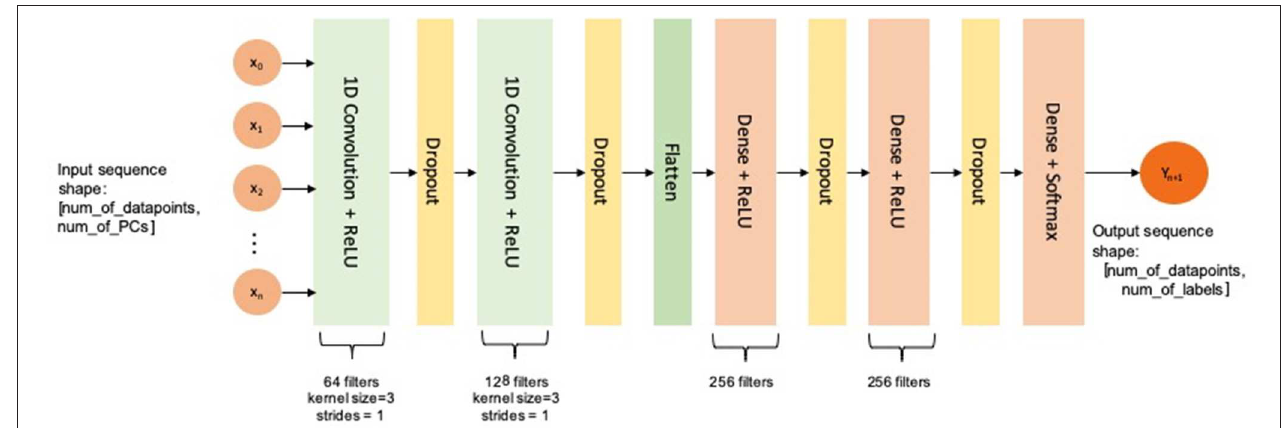
FIGURE 6 | Architecture of the CNN used for multi-label classification.